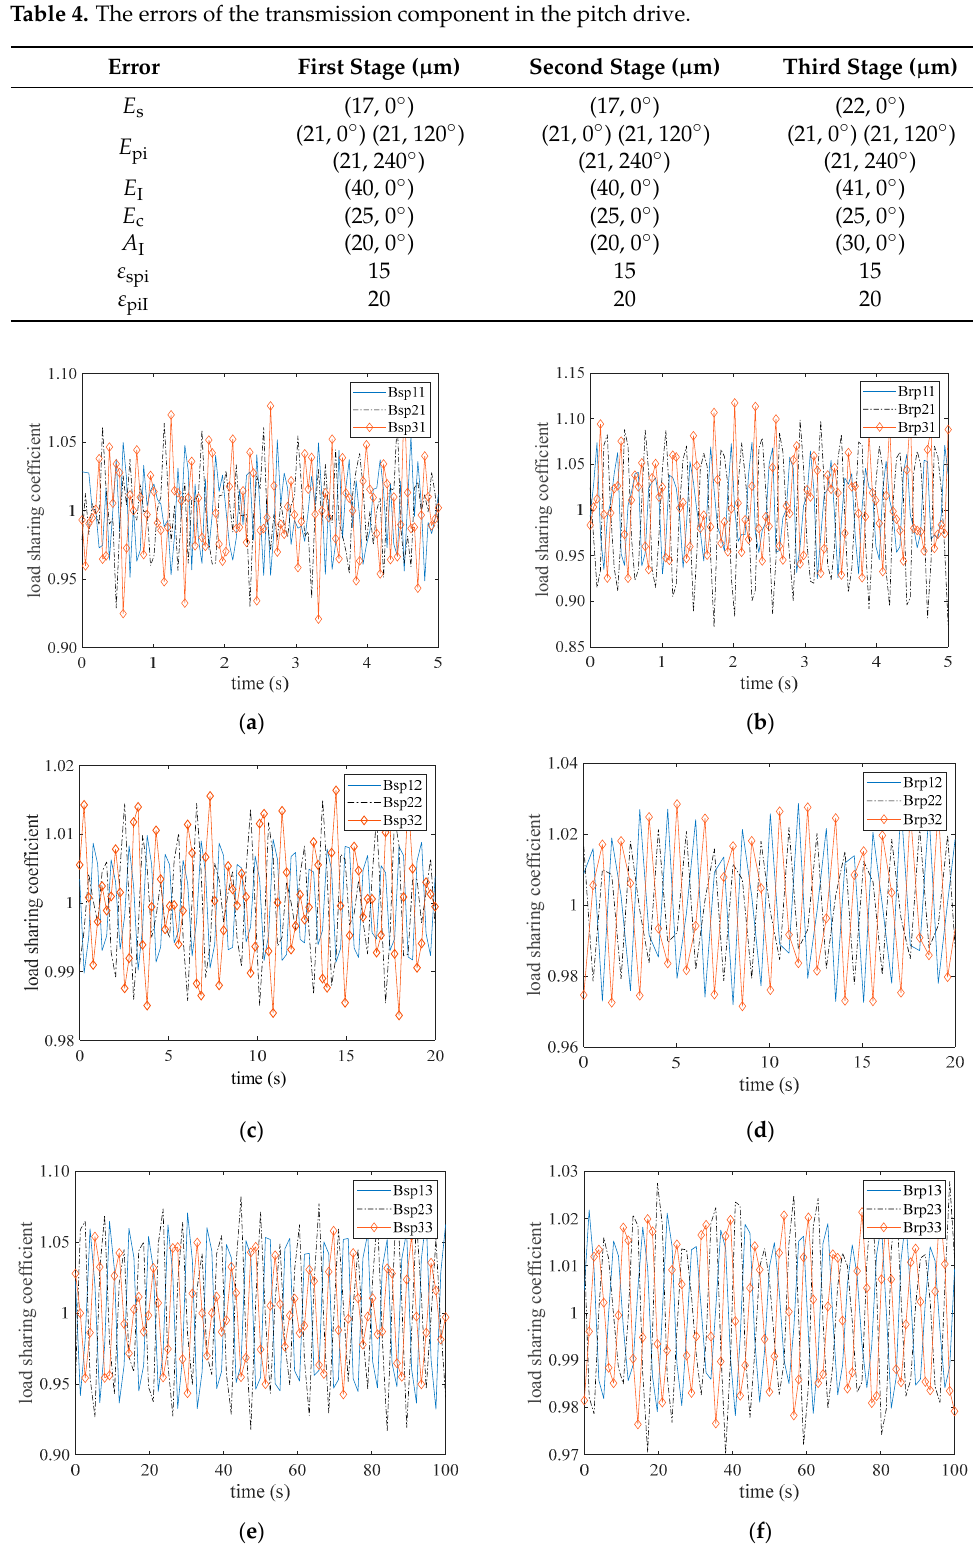
Figure 4. The load sharing coefficients for the internal and external meshing in all stages. ( a ) External meshing in the first stage; ( b ) internal meshing in the first stage; ( c ) external meshing in the second stage; ( d ) internal meshing in the second stage; ( e ) external meshing in the third stage; ( f ) internal meshing in the third stage.